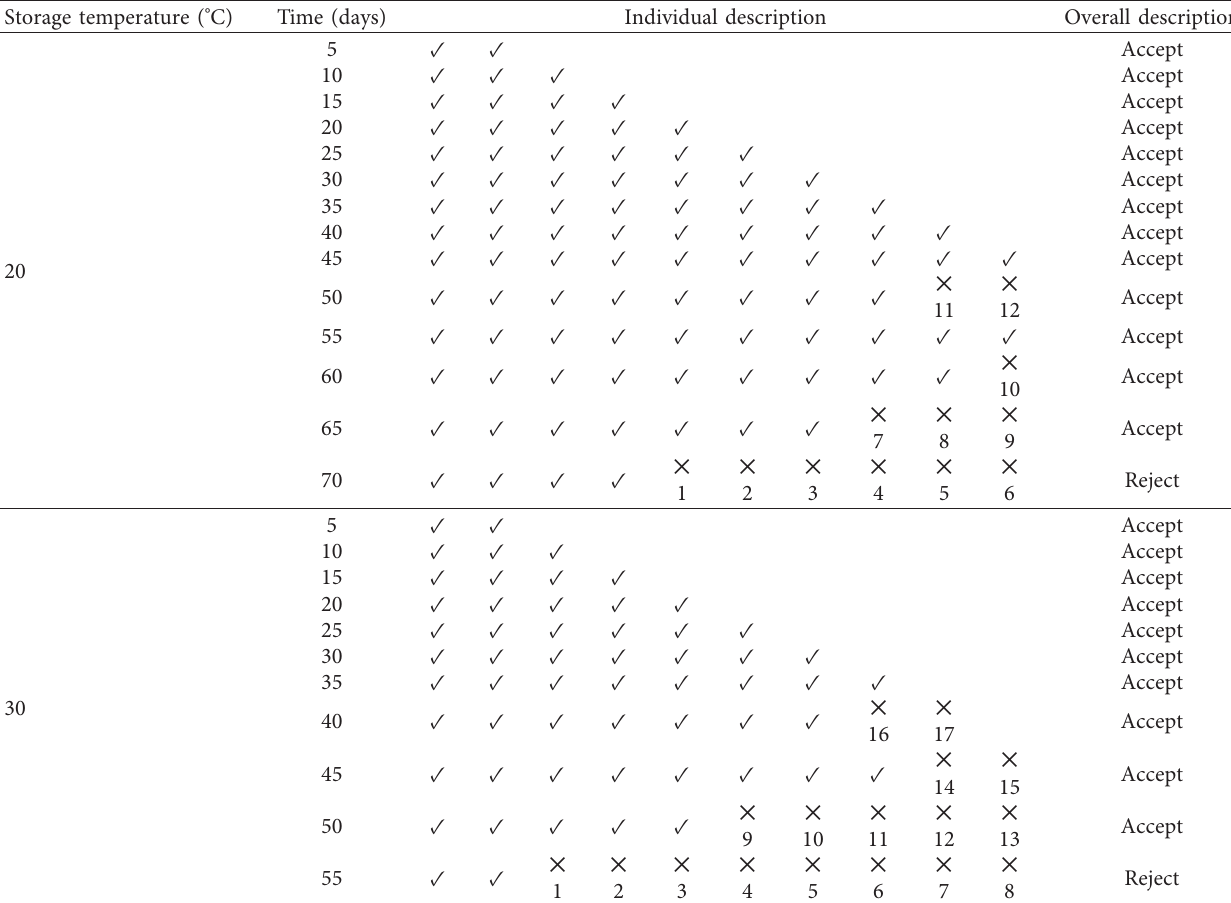
Table 4: Acceptability test of tea samples under the ASLT (20 ° C, 30 ° C, and 40 °